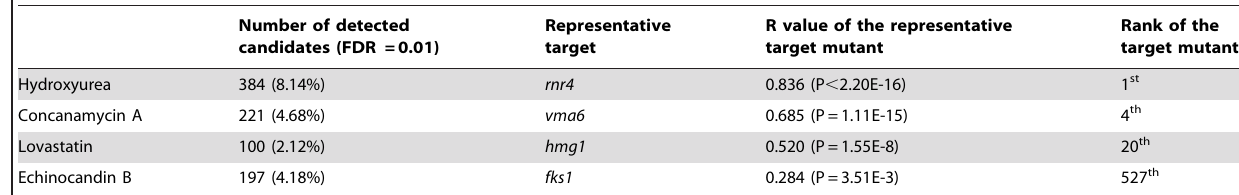
Table 2. Summary of the inference